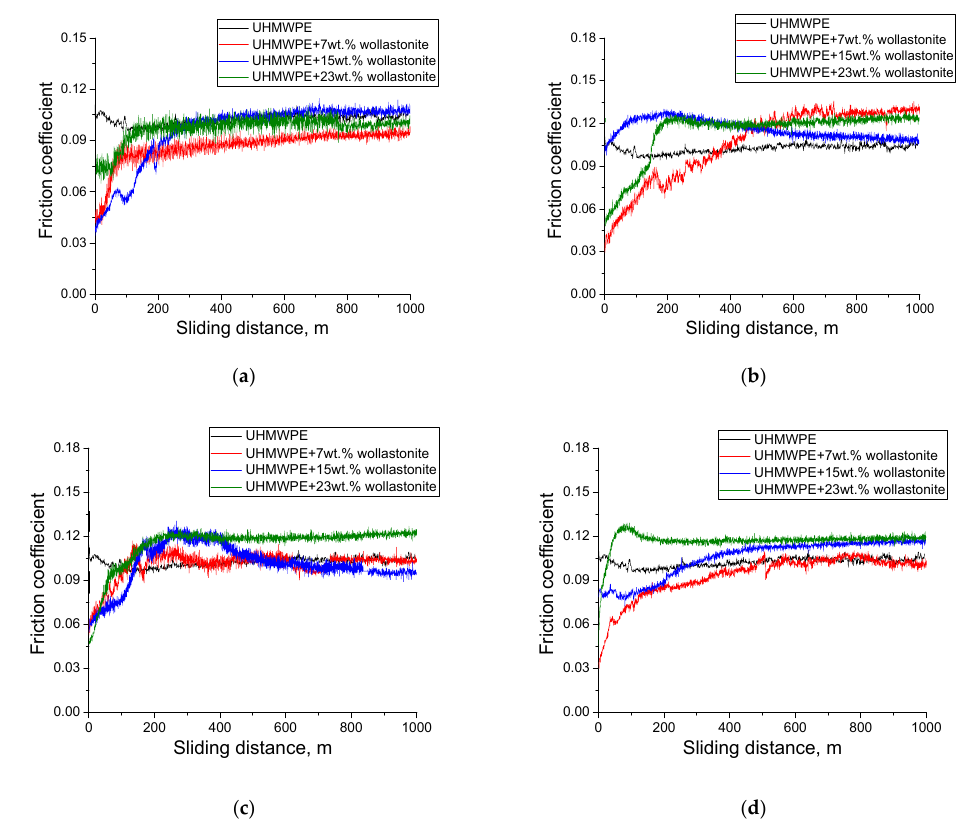
Figure 6. Diagrams on the friction coefficients vs. sliding distance: ( a ) without a silane-coupling agent and with ( b ) “KH-550”, ( c ) “Penta-1006”, and ( d ) “OTS”: the “pin-on-disk” scheme.